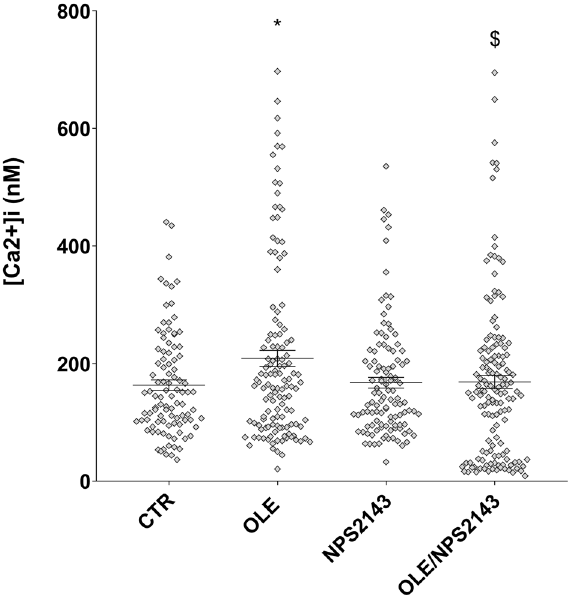
Figure 3. Effects of OLE on intracellular calcium concentration in MCD4 cells. MCD4 cells, loaded with Fura-2AM (4 μM for 15 min as described in methods), were stimulated with OLE (0.1 mg/ml O/N) in absence or in presence of NPS2143 (1 µM O/N). Intracellular calcium level was measured at steady-state and calibrated as described by Grynkiewicz 57 . Each sample was calibrated by the addition of 5 µM ionomycin in presence